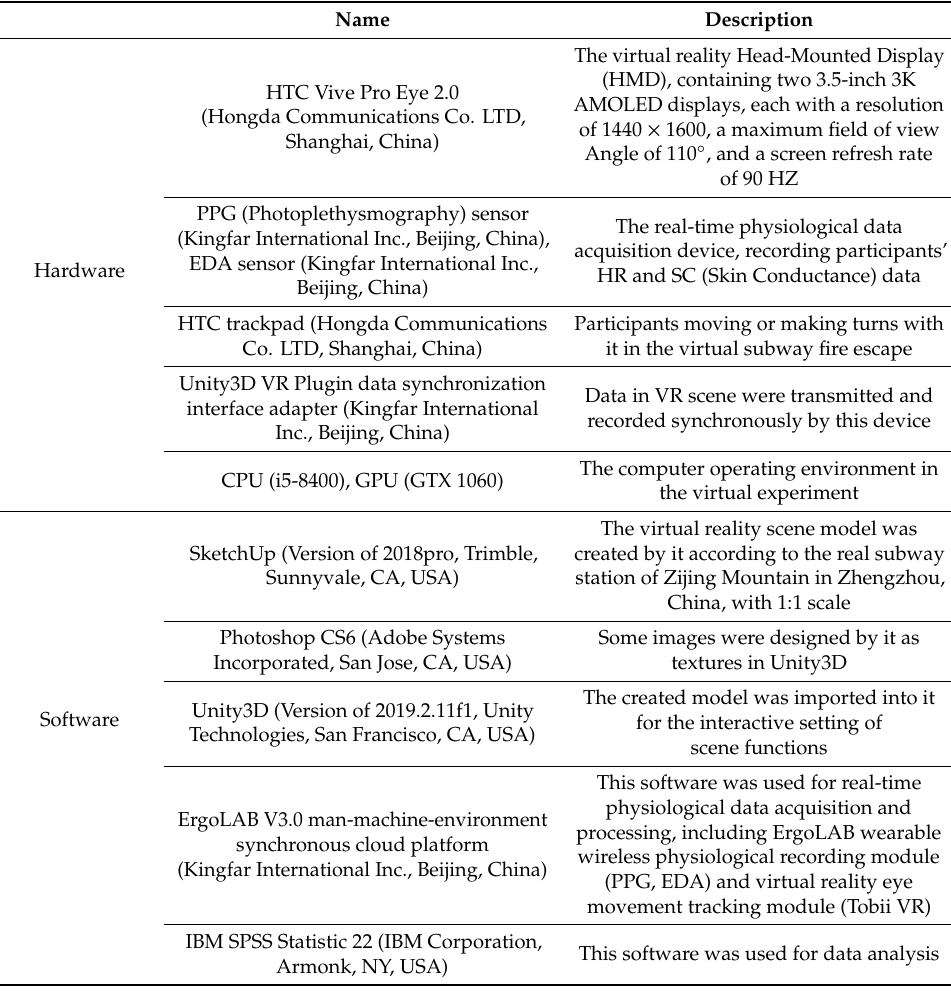
Table 2. The hardware and software used in the